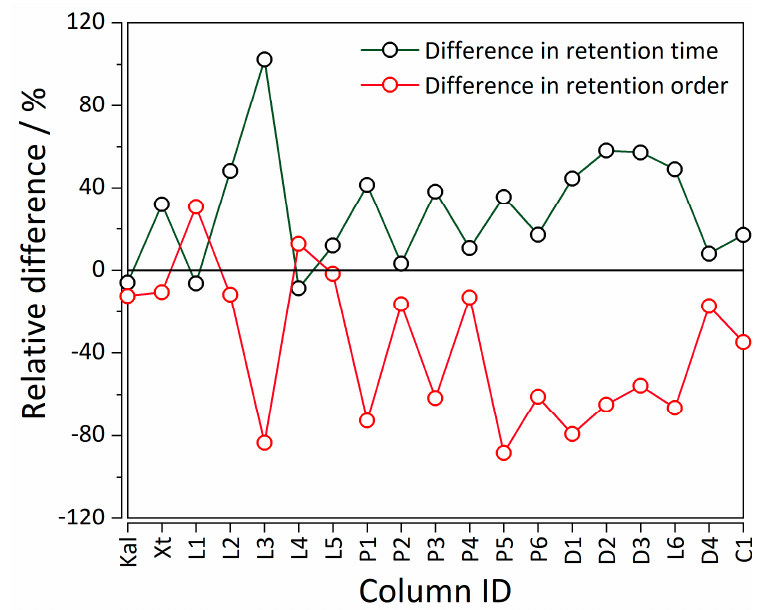
Figure 4. Relative difference in retention time and elution order %RMSE values between MLR and MLR-NLP models. The legend for the X-axis is analogous to the one in Figure 2. Abbreviations: %RMSE—percentage root mean square error, MLR—multiple linear regression, MLR-NLP—MLR–non-linear programming.